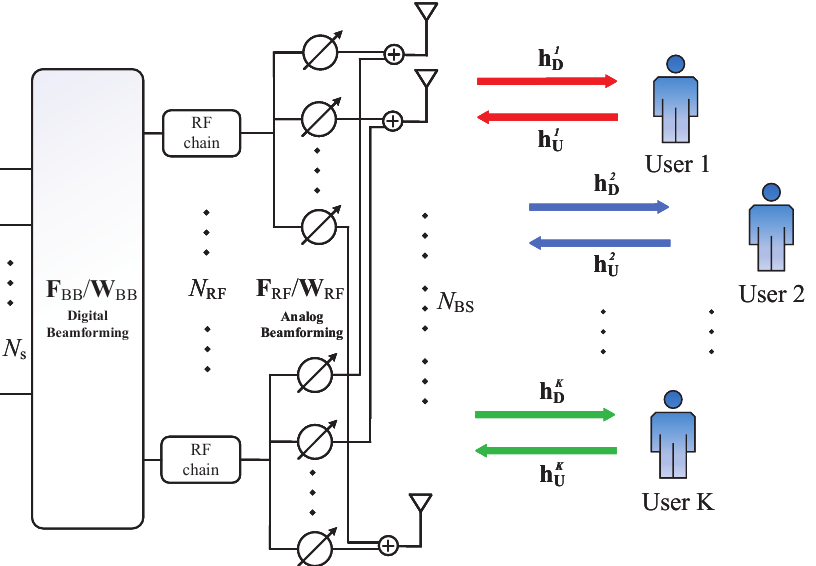
Figure 1. Block diagram of the multi-user mmWave massive MIMO